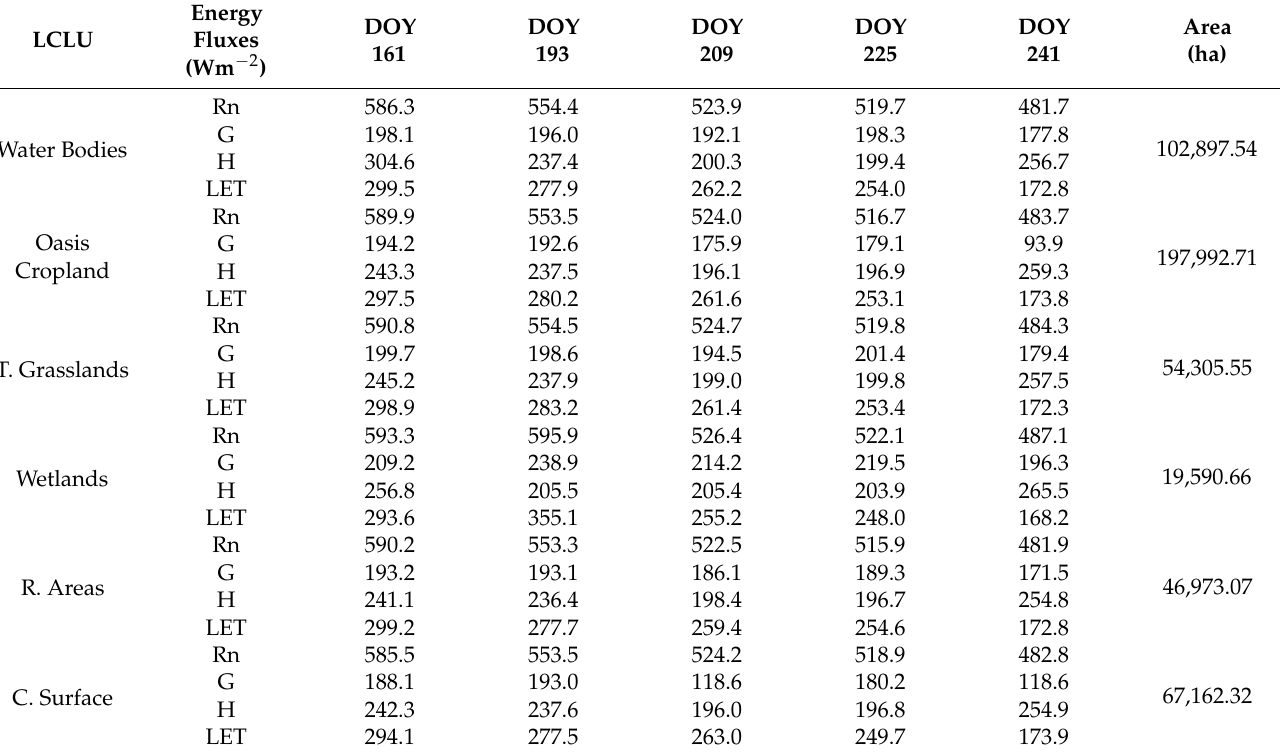
Figure 5. Spatial mean variation of surface energy components across Yanqi basin during the summer season (Rn: Net Radiation, G: Ground heat fluxes, H: Sensible heat flux, and LE: Latent heat flux). Table 2. Mean distribution of surface energy fluxes across Yanqi land-use types.